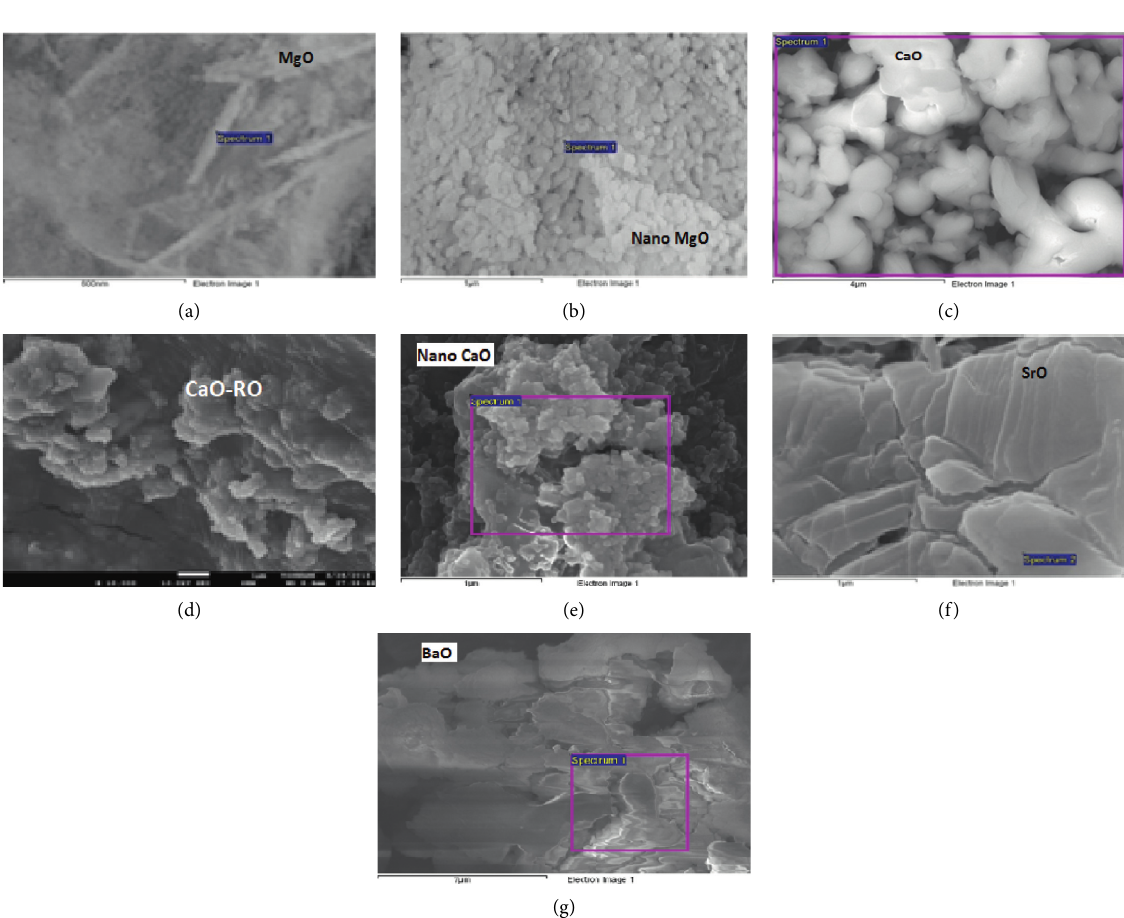
Figure 2: TEM images of catalysts (a MgO, b Nano MgO, c CaO, d CaO RO, e Nano CaO, f SrO, g